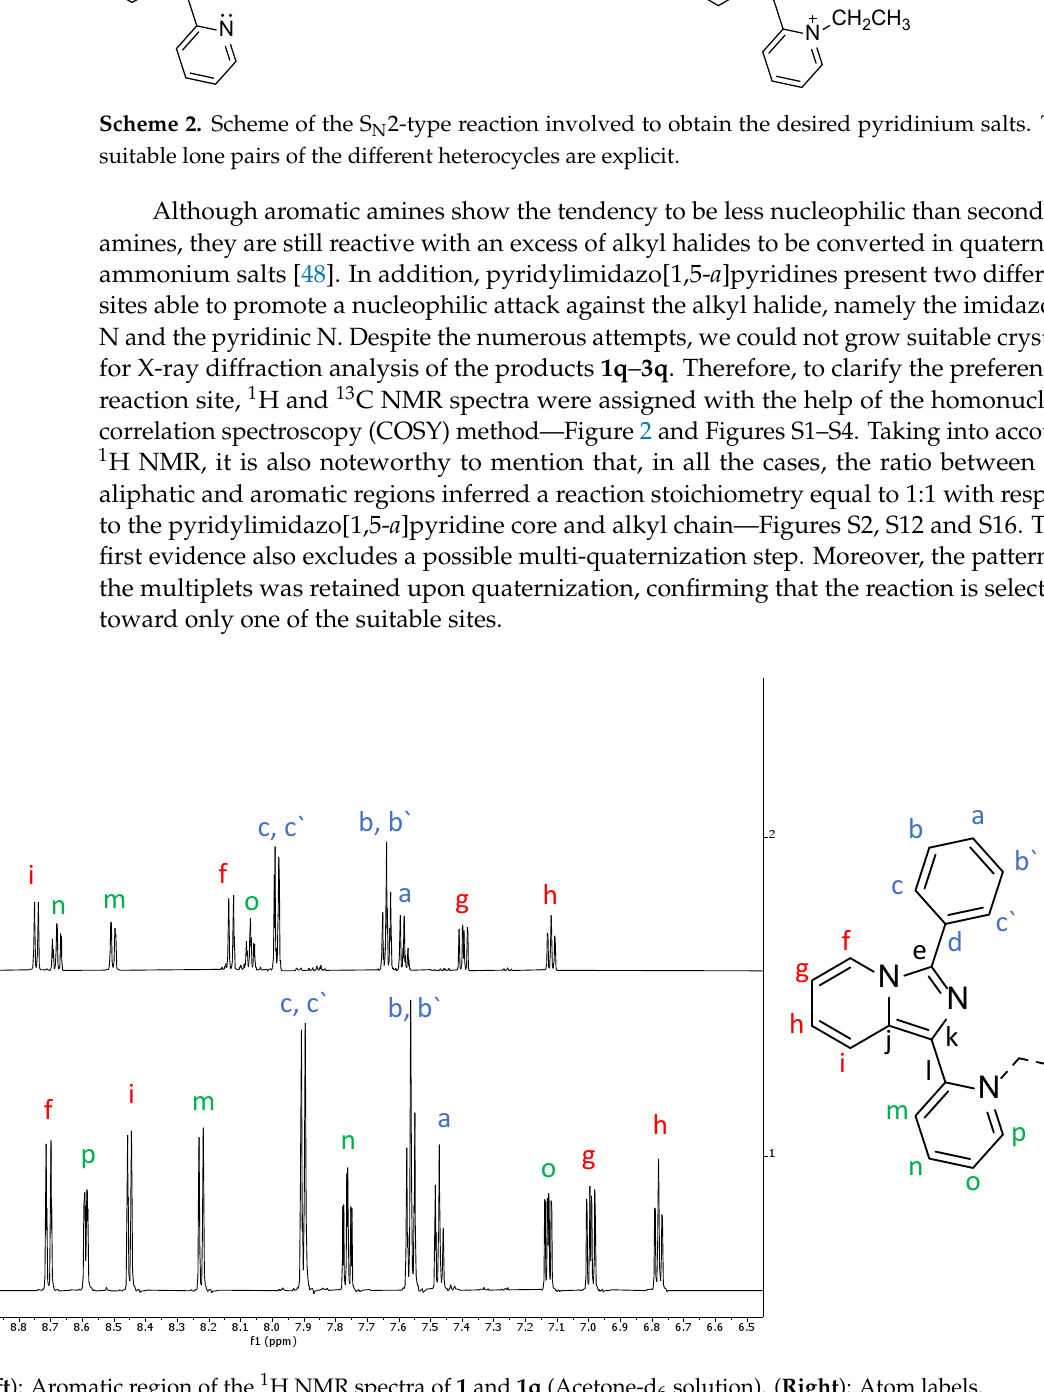
Scheme 2 . Scheme of the S N 2-type reaction involved to obtain the desired pyridinium salts. The suitable lone pairs of the different heterocycles are explicit.